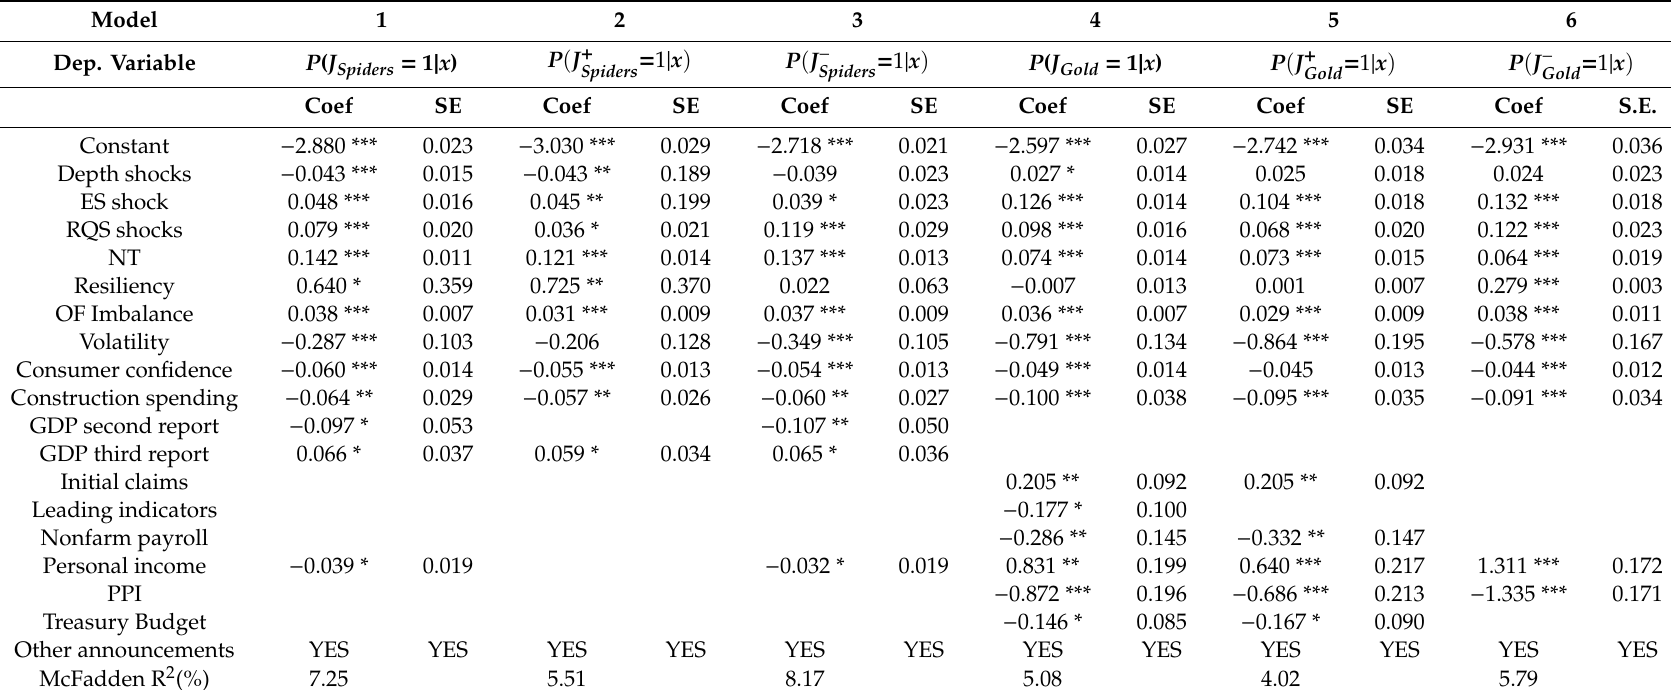
Table 4. Impact of macroeconomic news surprises on